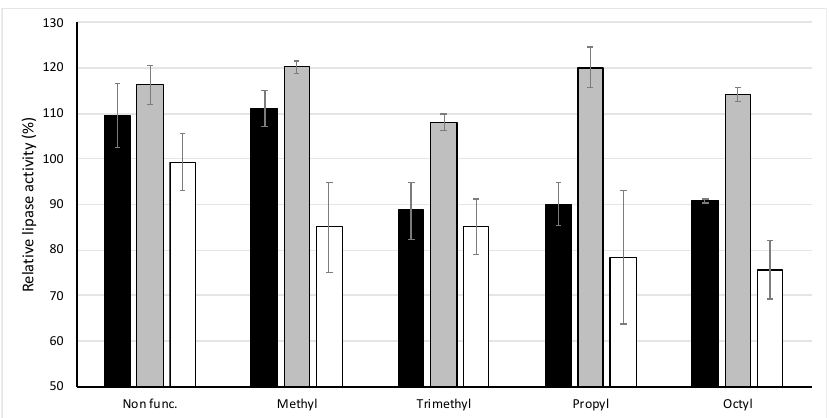
Figure 3. Lipase activity in the absence of bile salt (NaTC). Black column U-Cx; Grey column MS-Cx and white column SP-Cx.